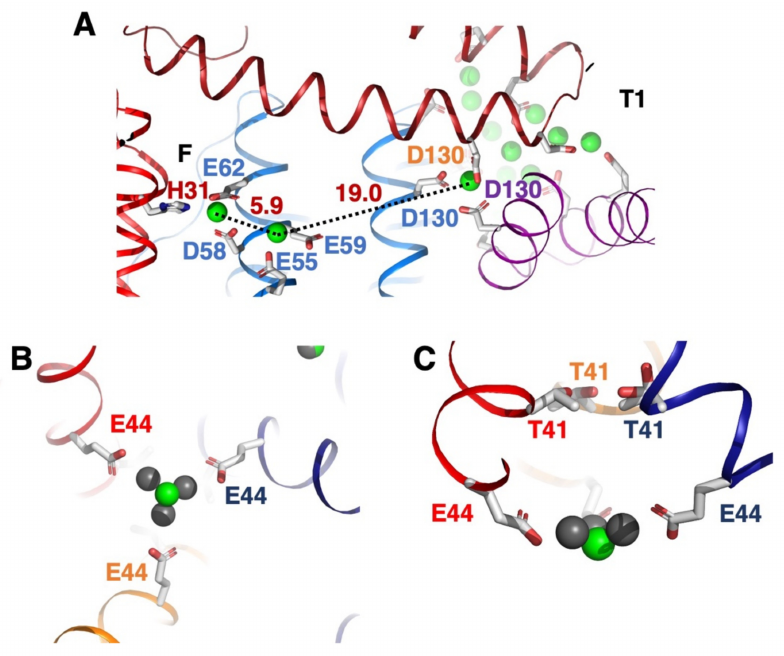
Figure 4. ( A ) Architecture of T1 to FOC of Dps Yb 120 in cartoon representation. Yb 3+ ion is shown as a light green sphere. The residues of one subunit along the 3-fold axis are represented by sticks and marked according to the amino acid sequence. ( B ) Architecture of the T2 pore viewed from the inside of Dps Yb 120 in cartoon representation. ( C ) Architecture of the T2 pore viewed from the